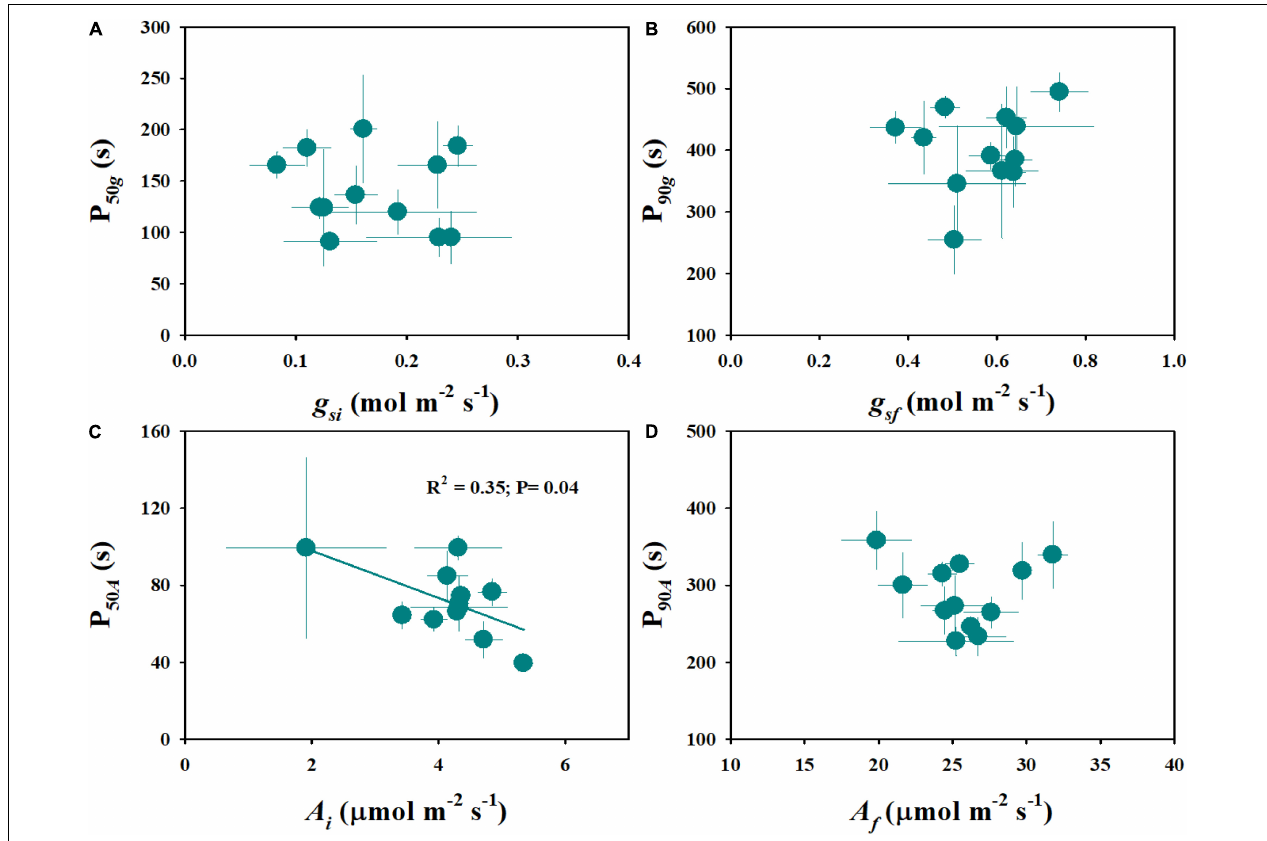
FIGURE 5 | Relationship between steady-state and non-steady-state gas exchange. (A,B) Initial stomatal conductance ( g si ) and initial response rate of stomatal conductance (P 50 g ), final stomatal conductance ( g sf ), and final response rate of stomatal conductance (P 90 g ). (C,D) Initial photosynthetic rate ( A i ) and initial response rate of photosynthetic rate (P 50 A ), final photosynthetic rate ( A f ), and final response rate of photosynthetic rate (P 90 A ). Points and error bars represent mean ± SD of three replications.